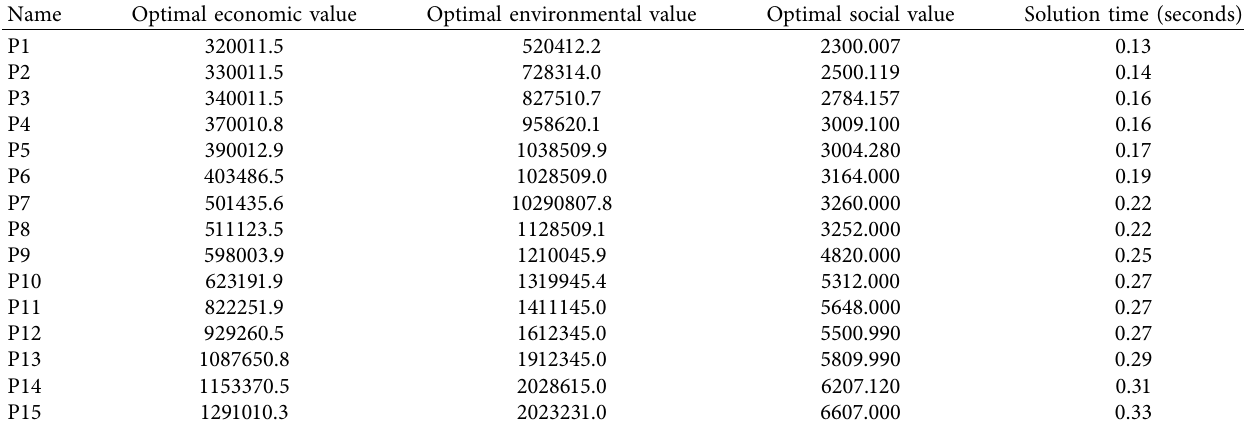
Table 8: Results of solving.